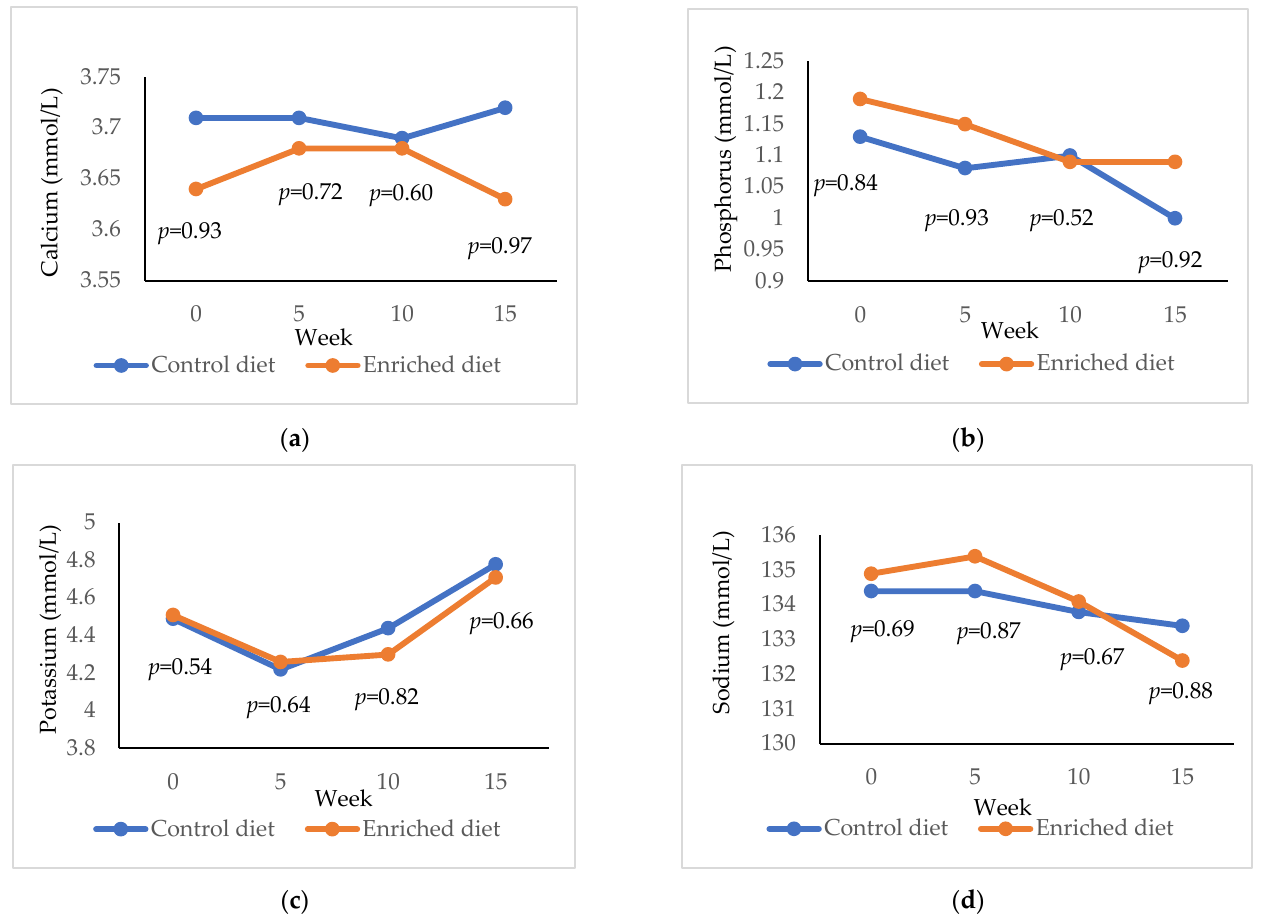
Figure 6. Evolution of ( a ) calcium; ( b ) phosphorous; ( c ) potassium; ( d ) sodium in males fed with Control and Enriched diet. p is the probability of the difference being >0 when the difference between the diets was >0 or being <0 when this difference was <0.